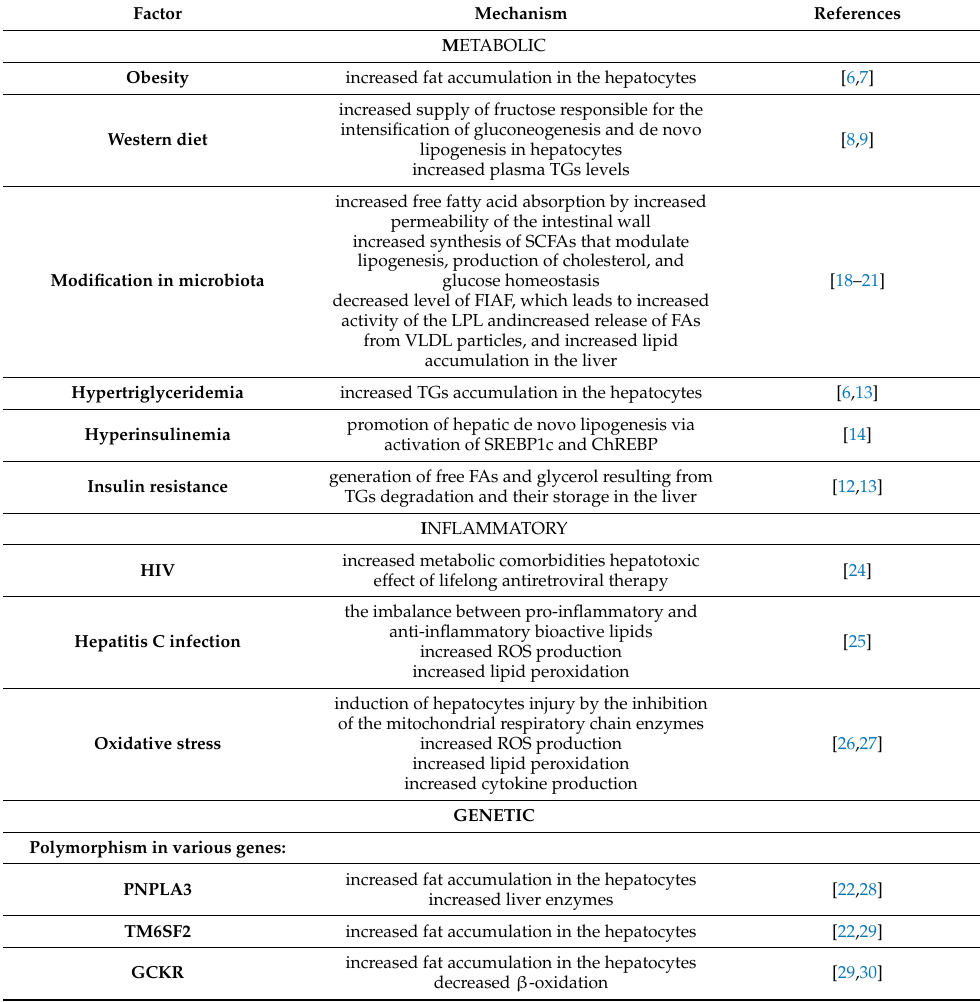
Table 1. The factors that promote MAFLD